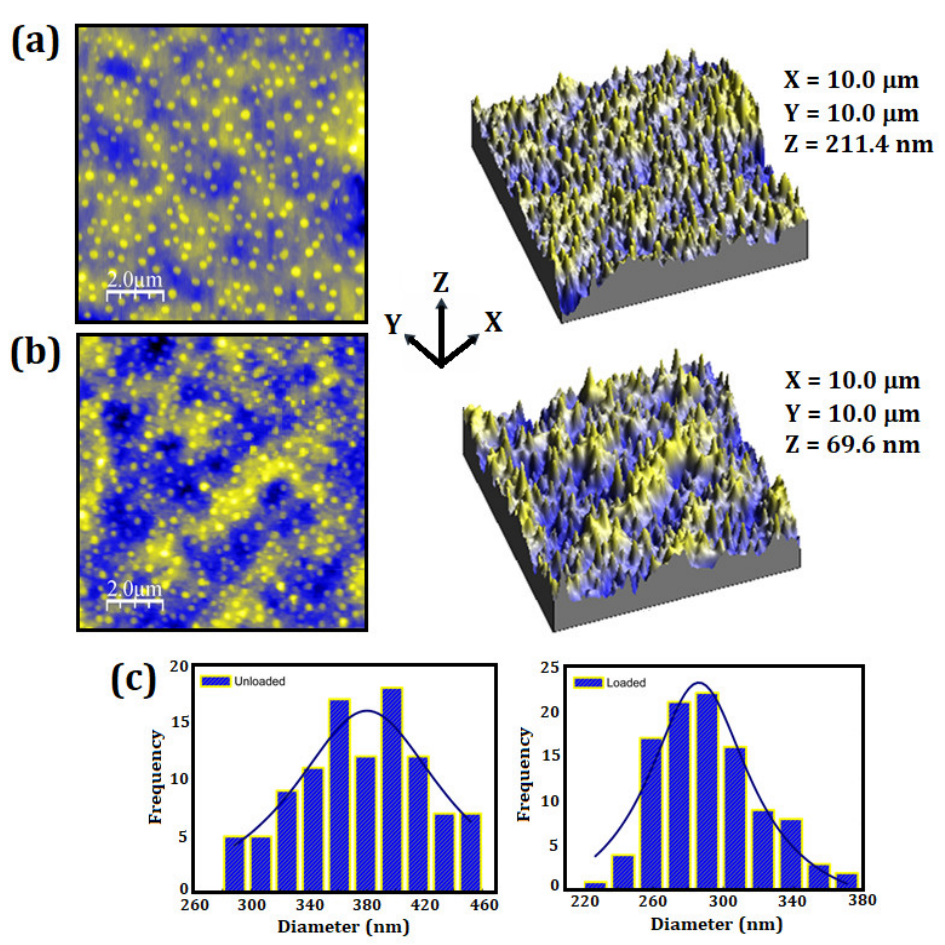
Figure 2. Two-dimensional and three-dimensional AFM micrographs: ( a ) unloaded particles, ( b ) loaded particles, ( c ) size distribution of unloaded and loaded particles.